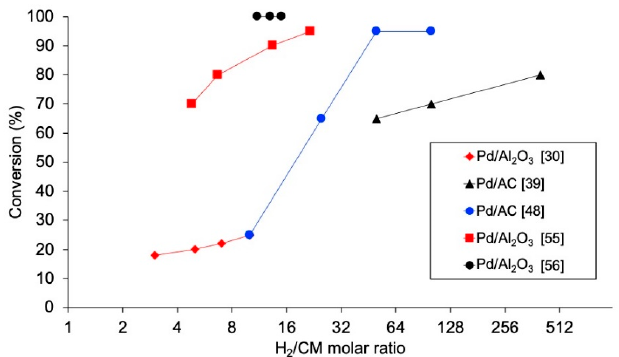
Figure 4. Evolution of the conversion of chloromethanes with molar ratio H 2 / CM in the HDC of DCM (black), TCM (blue) and TTCM (red) in the literature.